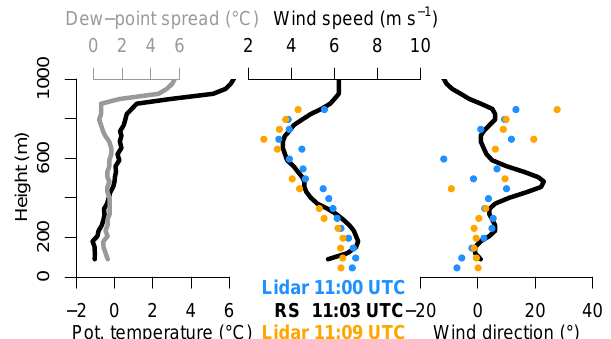
Figure 10. Vertical profiles of potential temperature, dew-point spread, wind speed and direction of radiosondes vs. lidar wind speed and direction for around 11:00UTC on 12 June 2016. A SNR threshold of − 23dB and elevations of 25, 50 and 75 ◦ were